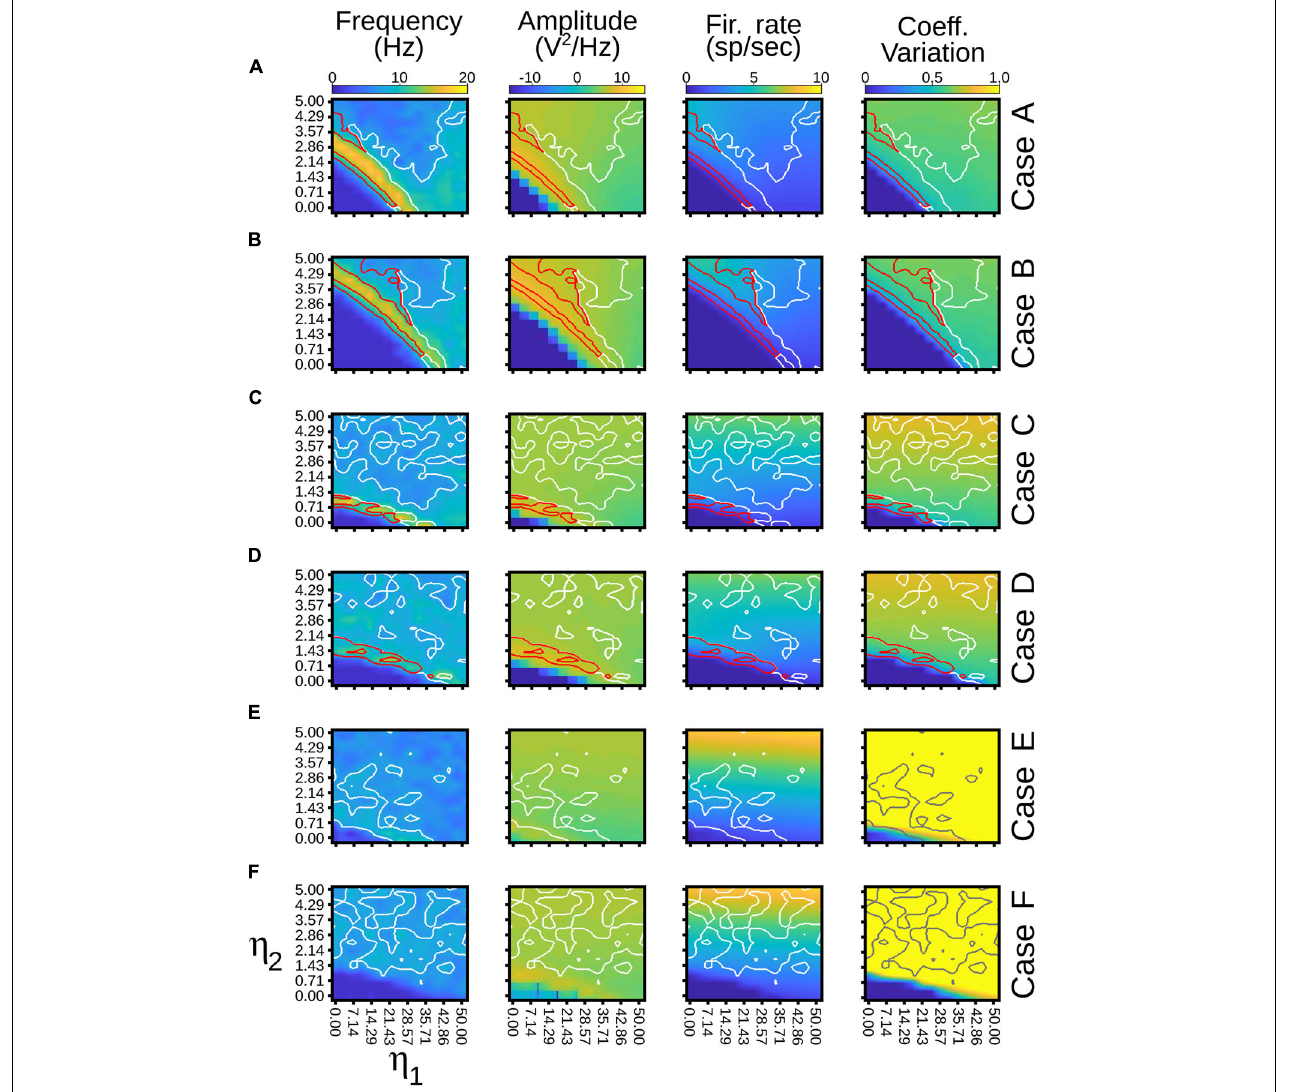
FIGURE 10 | Quantitative outputs for cases in Figure 9 . Frequency (Hz), amplitude (V 2 /Hz), firing rate (sp/s) and CV for different cases as η 1 and η 2 increase gradually. Red line, alpha waves with higher amplitude; white line, alpha waves with lower amplitude. Refer to the text for more